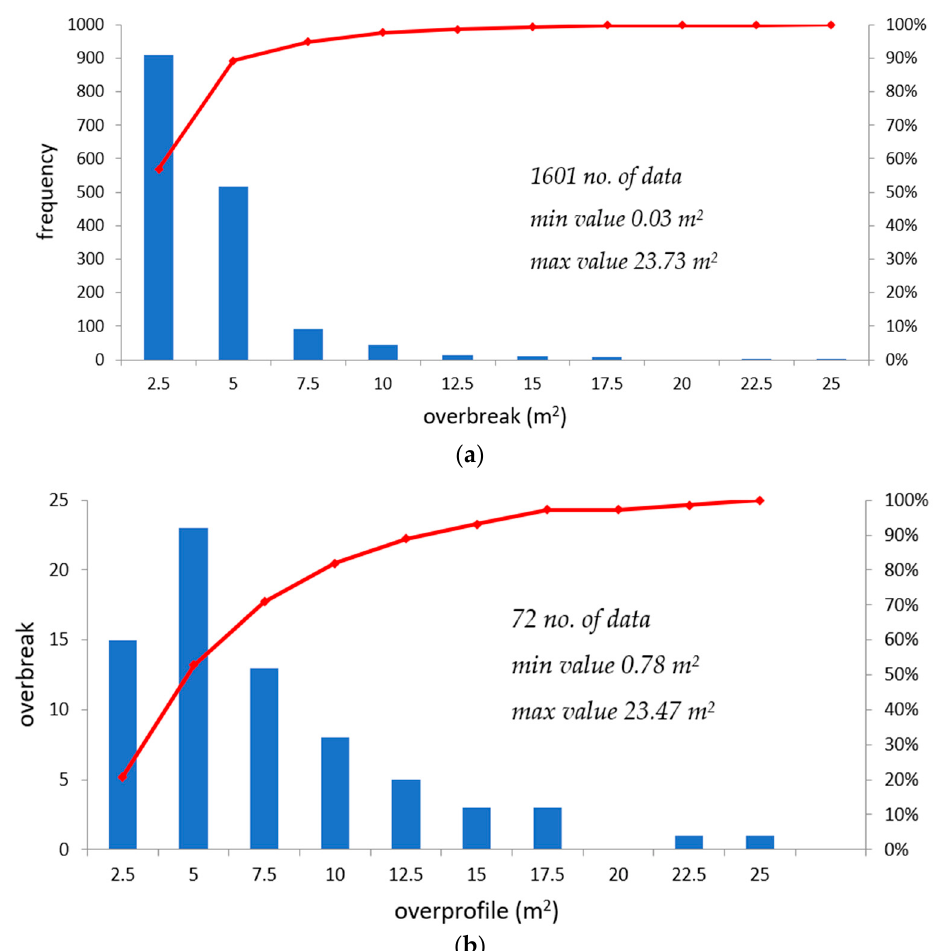
Figure 12. Histograms showing frequency of occurrence of overbreaks for ( a ) entire analysed length of tunnel and ( b ) stations in which geological overbreaks were identified by mapping.